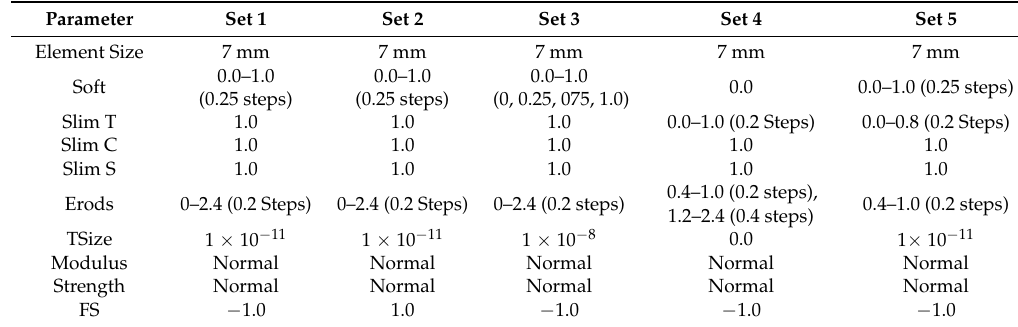
Table 7. Parameter used in different model runs (Part 1).